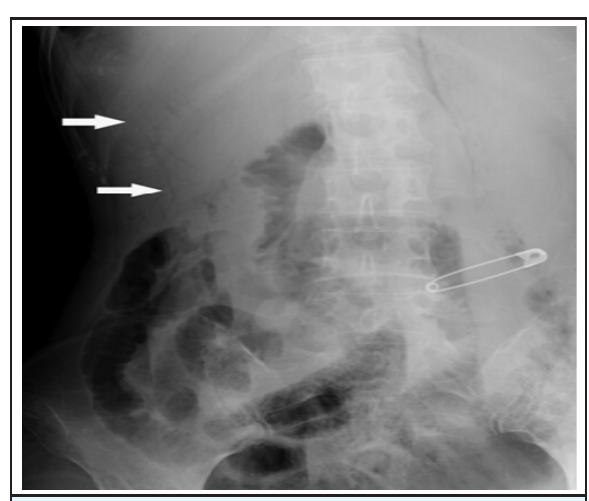
Figure 2b. Right–side-up decubitus abdominal radiograph shows multiple branching radiolucencies (white arrows) in periphery of liver shadow, which is indicative of portal venous gas. Dilated loops of small bowel are also present, which is consistent with small-bowel obstruction. Radiographs have been shown to be sensitive for